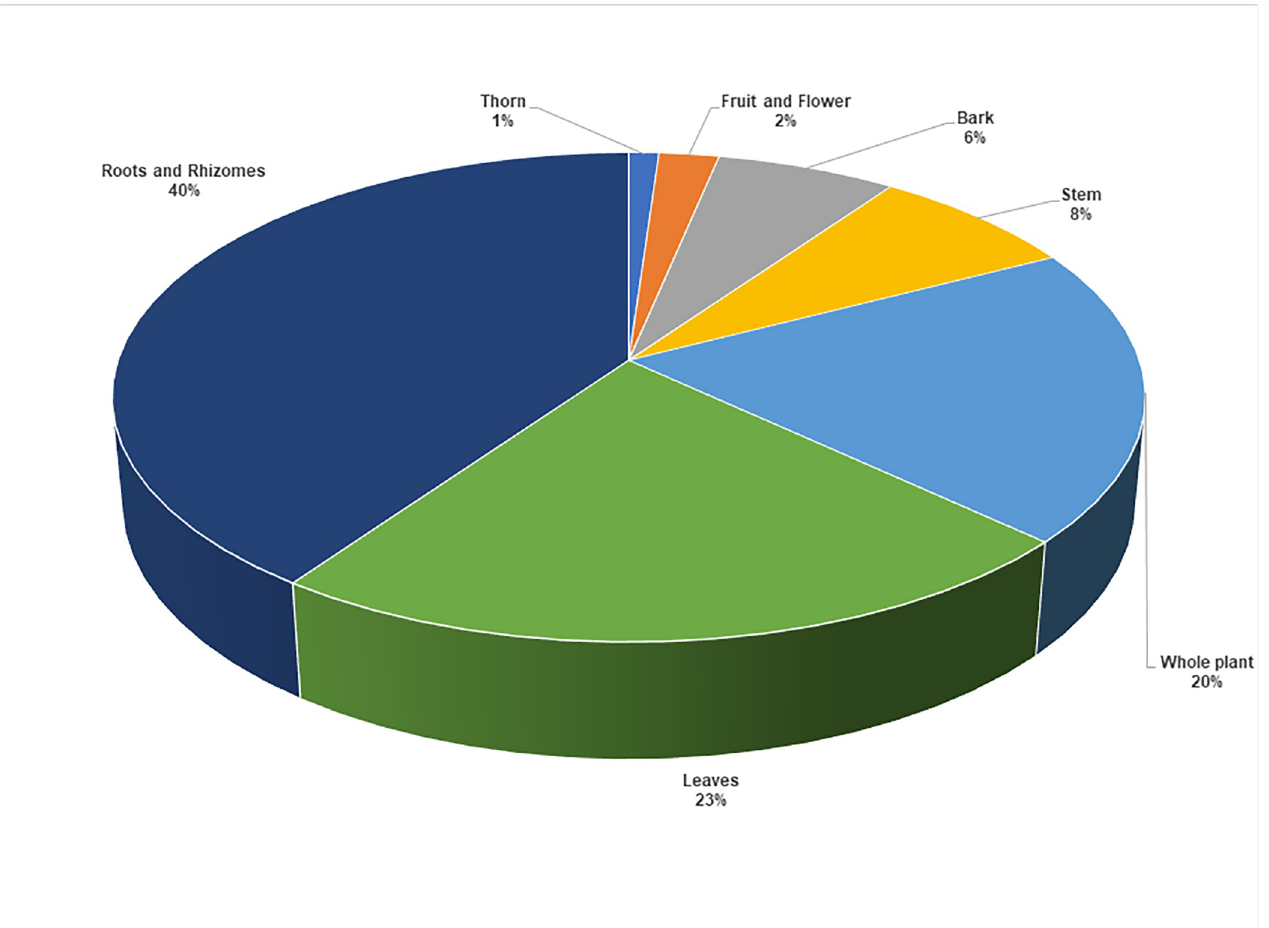
Fig 3. Distribution (%) of medicinal plant parts used to manage and treat childhood diseases in Ngaka Modiri Molema and Bojanala districts of North West Province, South Africa (n = 92).